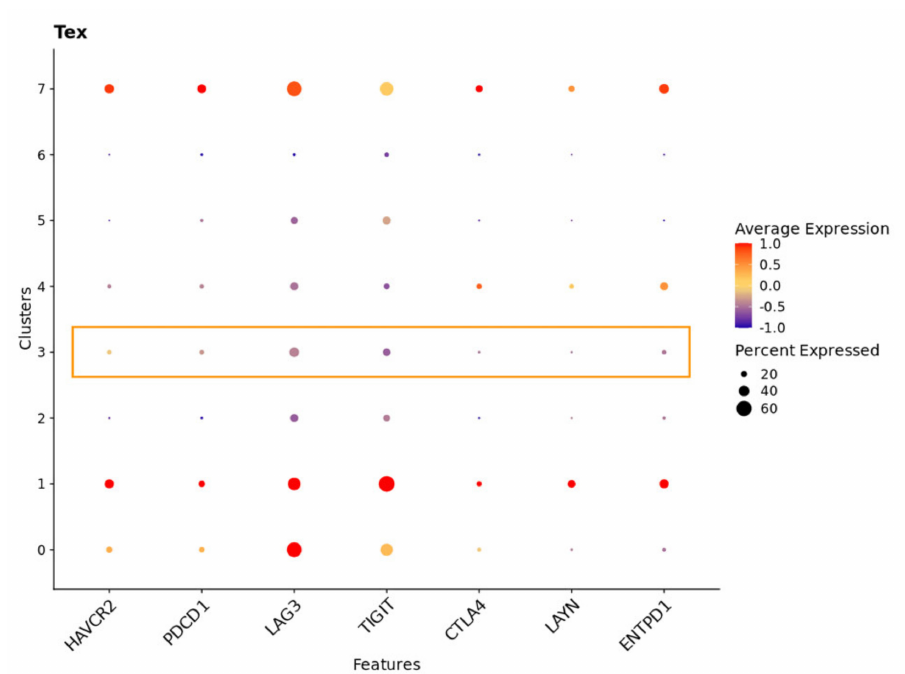
Figure 10. Cluster 1 and cluster 7 were identified CD8+ T cell sub-clusters with CD8+ T EX features. The x -axis is the interested gene, with scaled average expression (low to high: − 1.0 to 1.0) and a larger dot indicating a higher percentage of expression of interested genes in the total analyzed cells. The y -axis is the identified CD8+ T cell sub-clusters.